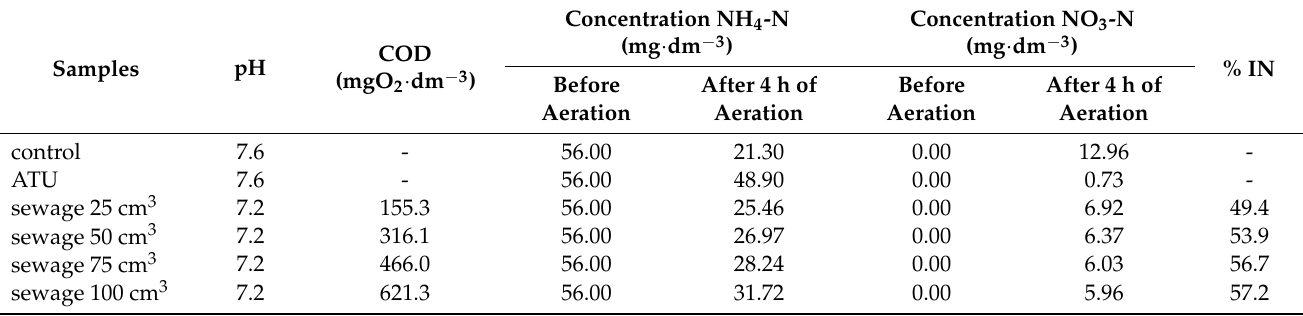
Table 10. Influence of COD of industrial wastewater from owipian ® production on the nitrification inhibition in activated sludge under laboratory